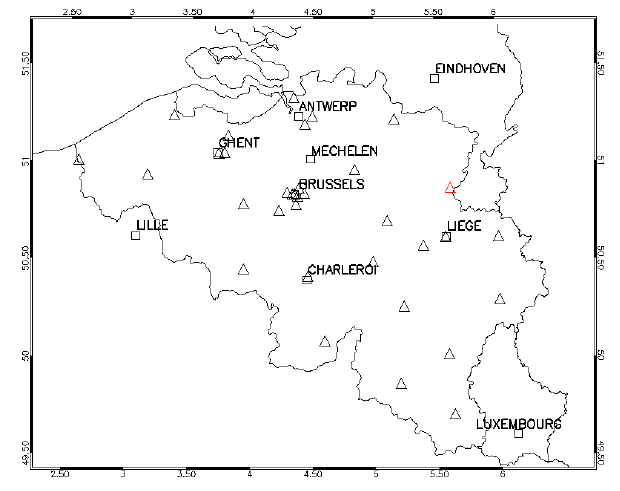
Figure 2. Overview of the 3km model domain and the location of major cities (white squares) and observation stations (white trian- gles). The location of station “Lanaken” is indicated with a red tri-